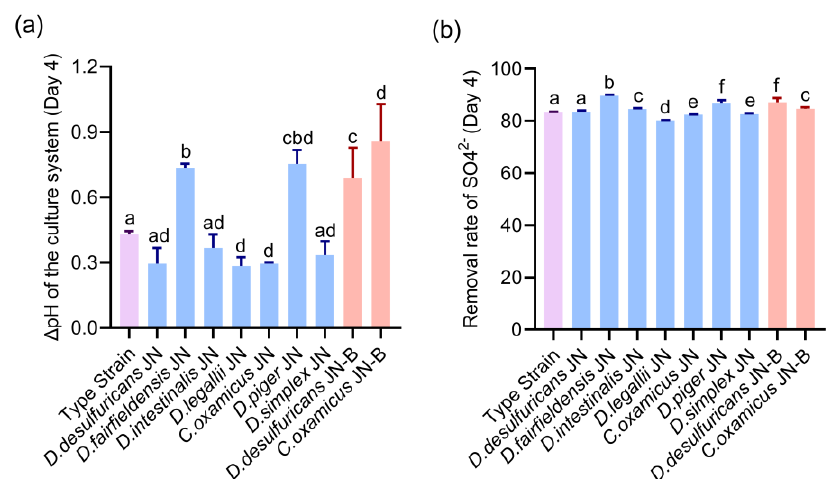
Figure 3. Desulfurization performance evaluation on Desulfovibrio from the human gut. ( a ) The change of the medium’s pH value from day 0 to day 4. ( b ) Comparison of SO 42 − removal rate. The type strain was D. desulfuricans ATCC 29577. The Blue bars were the strains from healthy volunteers, and the red bars were the stains from patients with liver cirrhosis, and the data are given as the means ± standard error of the mean (s.e.m.). Differences were identified using the t -test and One-way ANOVA statistical analysis, and different superscripts indicate significant differences ( p <